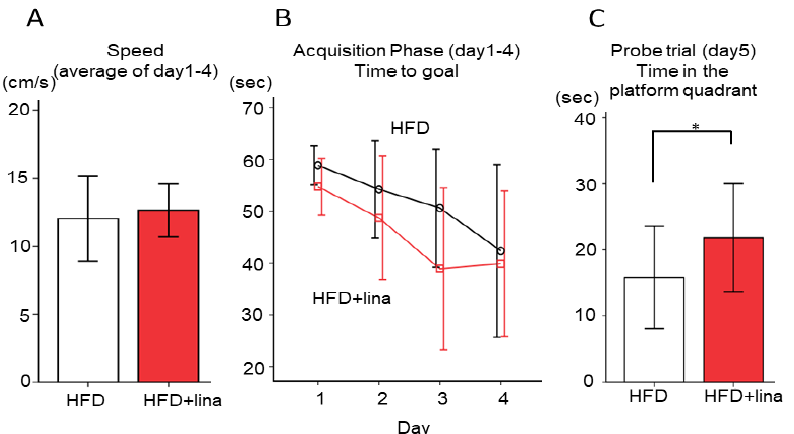
Figure 3. Effects of linagliptin on cognitive function as assessed by the Morris water maze test.